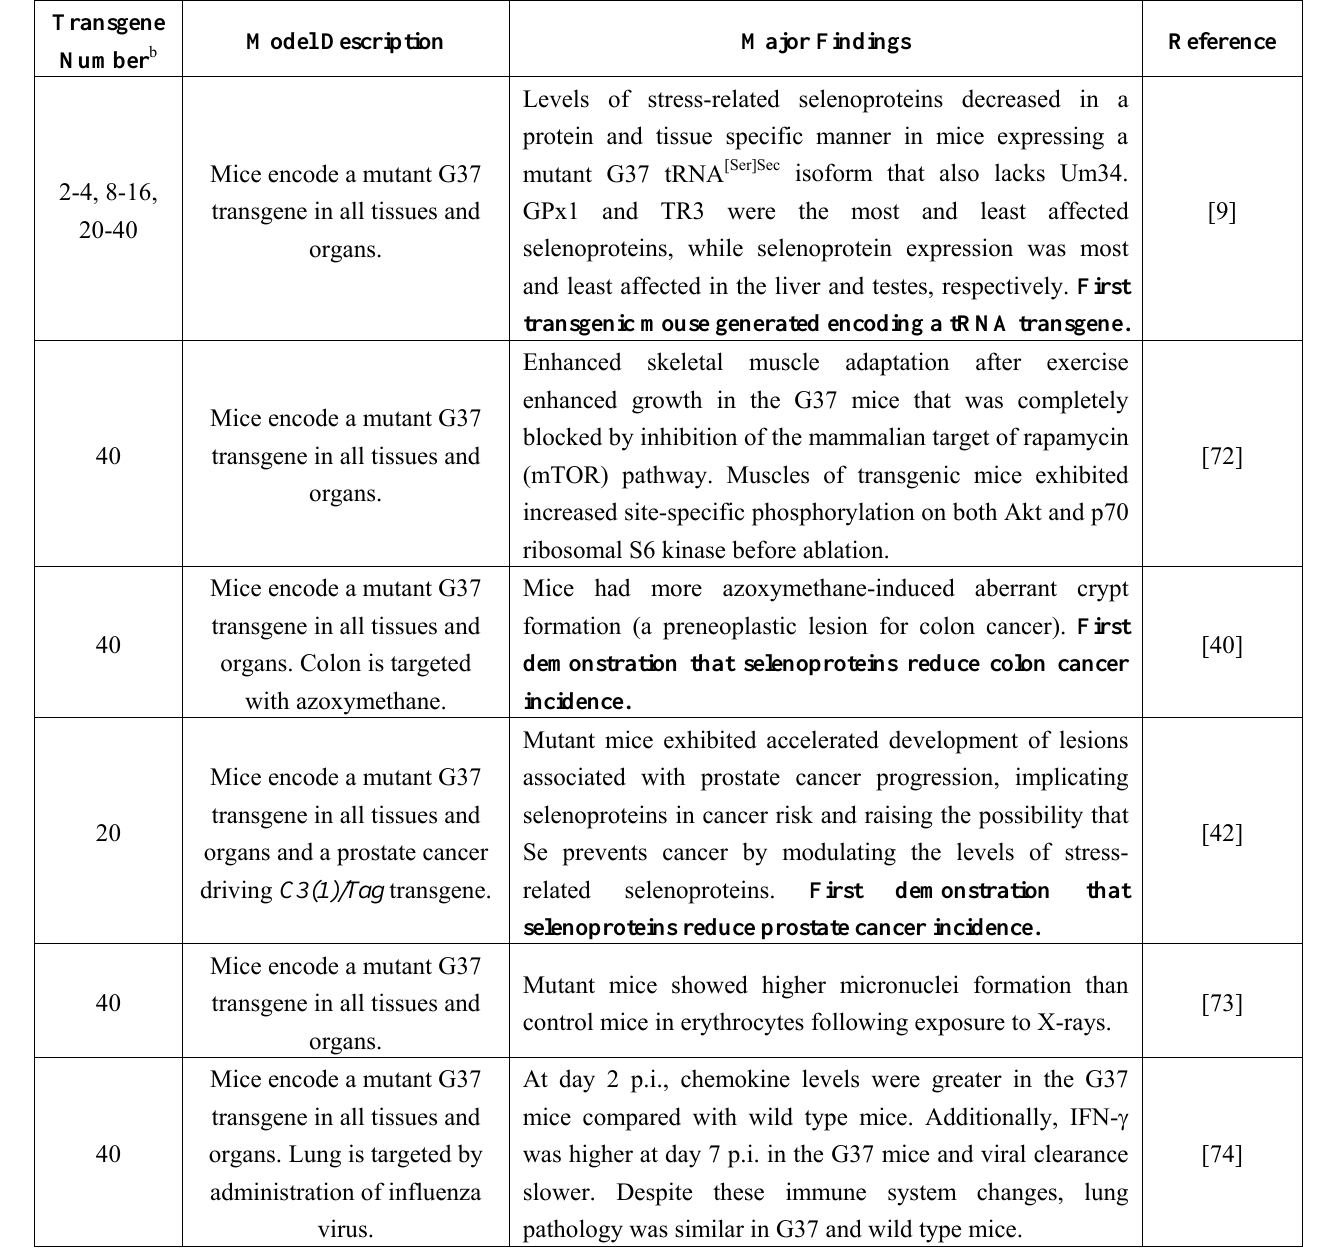
Table 1. G37 mutant Trsp transgenic mouse models.